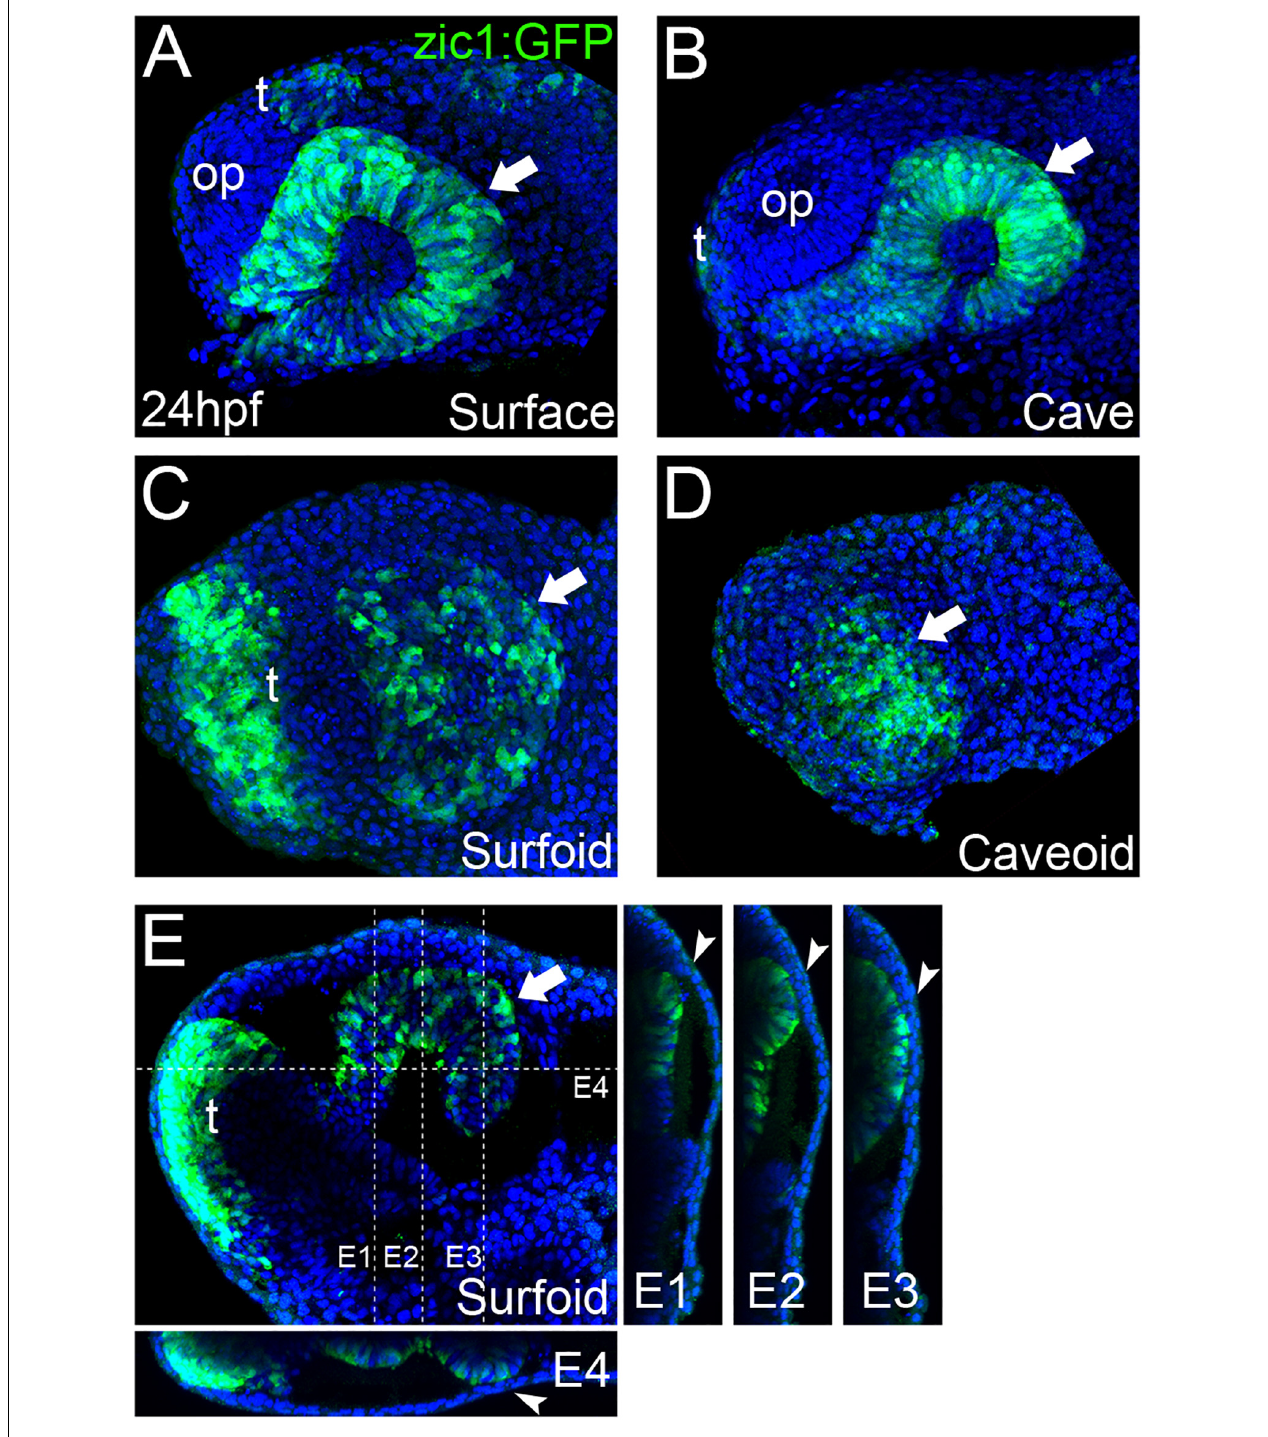
FIGURE 3 | Eye development in Astyanax pescoids. GFP-reporter expression in zic1:GFP transgenic surface and cavefish intact embryos [ (A,B) , respectively], and surfoid (C,E) and caveoid (D) at 24 hpf. Embryos and pescoids are oriented in lateral views, anterior to the left. Arrows indicate the GFP-expressing optic tissue; op, olfactory placode; t, telencephalon. Confocal reconstructions at the indicated levels in (E) are shown (E1–E4) . Arrowheads (E1–E4) indicate the contact zone between neural and non-neural ectoderm.